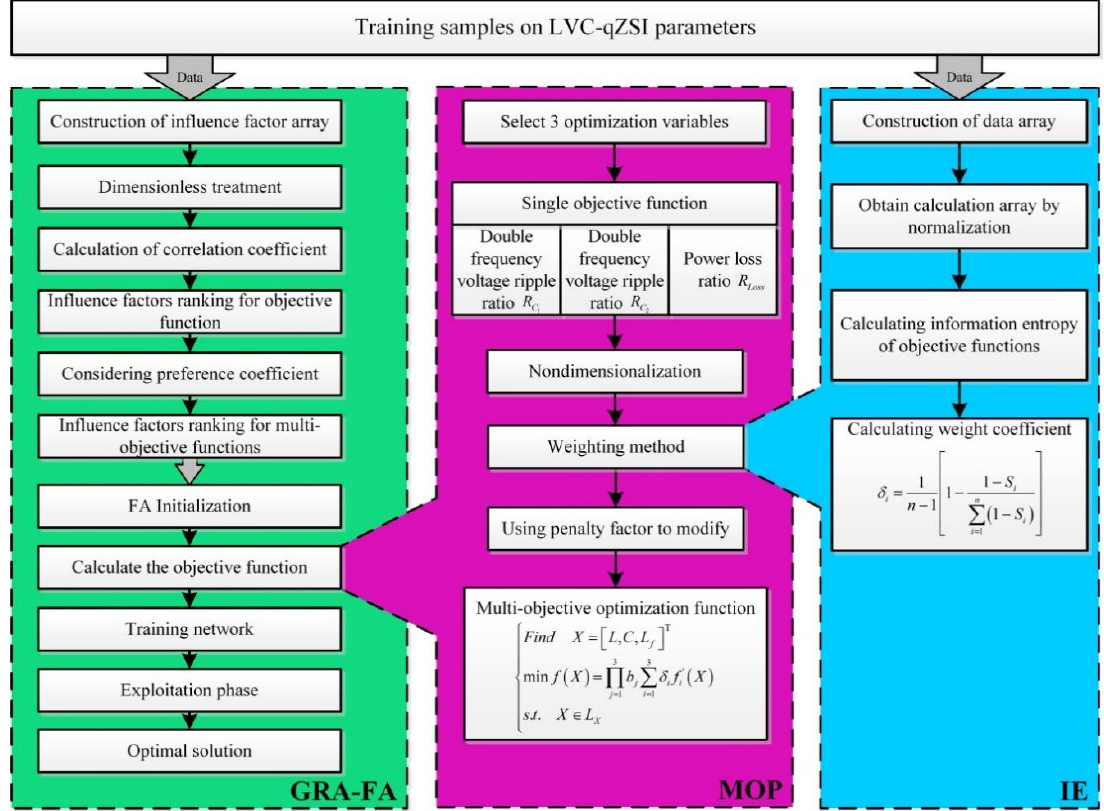
Figure 8. Integration optimization strategy of LVC-qZSI parameters based on GRA-FA.